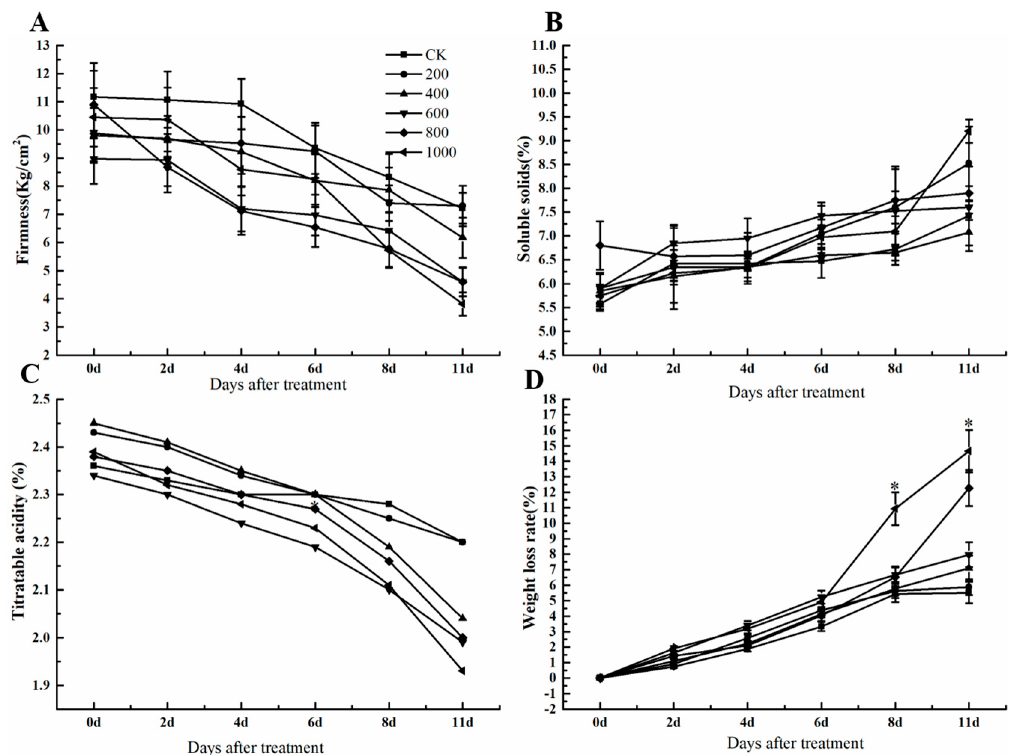
Figure 2. Effect of ethephon on soluble solids, titratable acidity, firmness, and weight loss rate in grape. ( A ) Fruit firmness. ( B ) Fruit soluble solids. ( C ) Titratable acidity. ( D ) Weight loss. Ethephon was